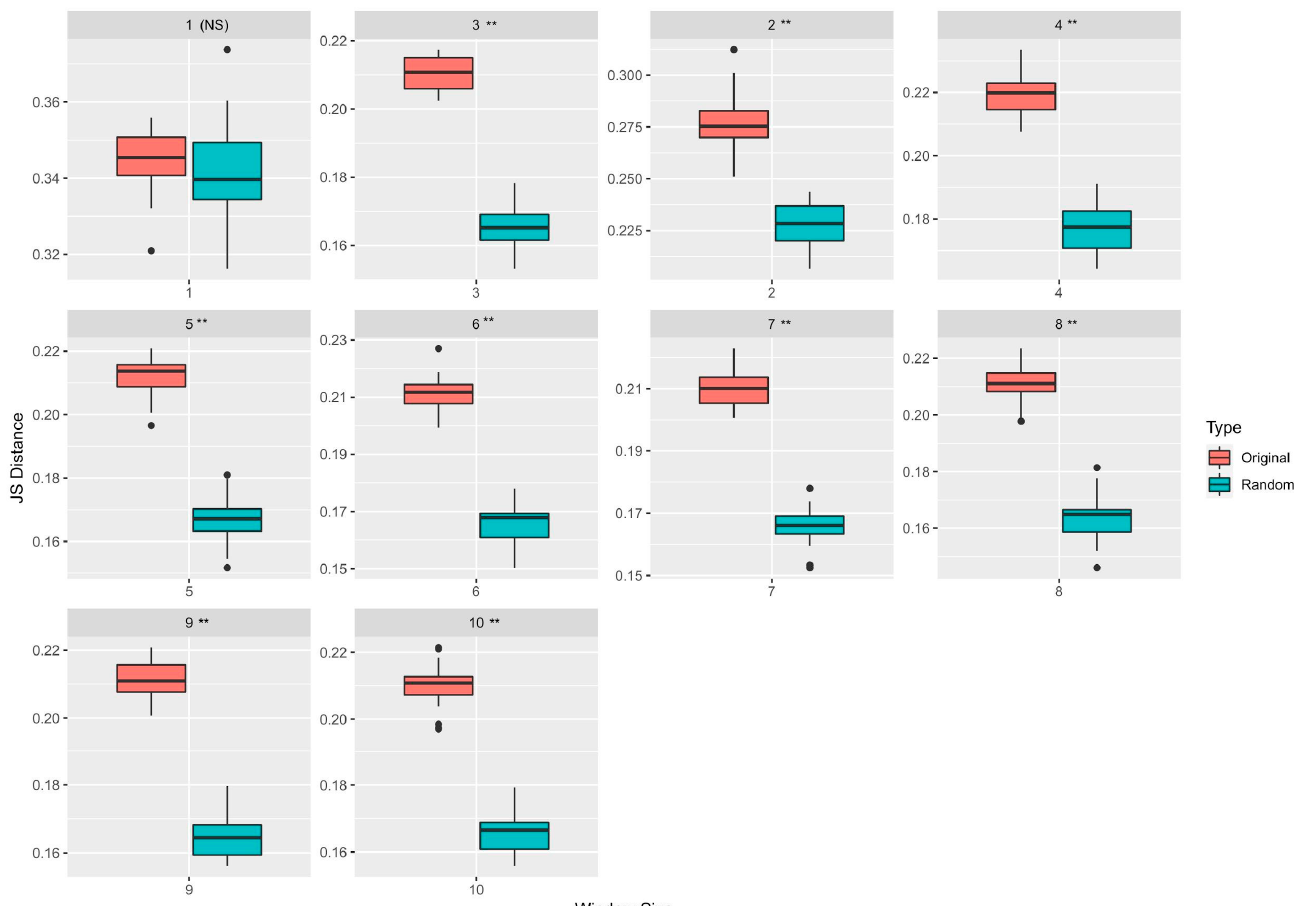
Figure 2. KDE estimation results: Variation in JS distances between the estimated densities for every window size between 1 and 10 is shown in this figure. All 5265 mutations from the original study were used here. Two types of boxplots, one for the original and another for the randomized experiments, have been shown here along with the p -values, which approximates the probability that the original median distance can be obtained by chance. Except for window 1, all other window sizes had a significant (** p < 0.05) difference between the original and the randomized JS distances. (NS = Not Significant)